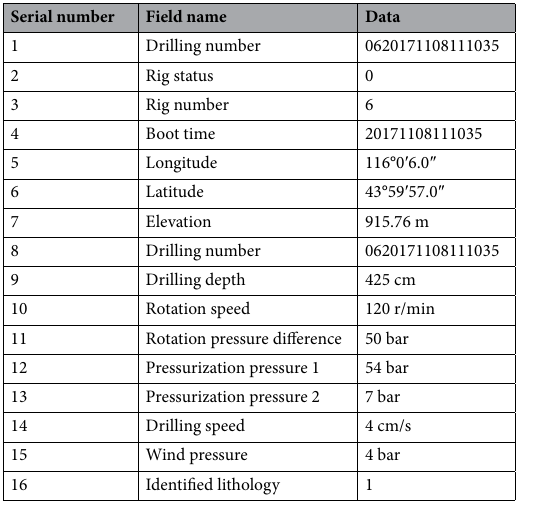
Table 1. Blast hole